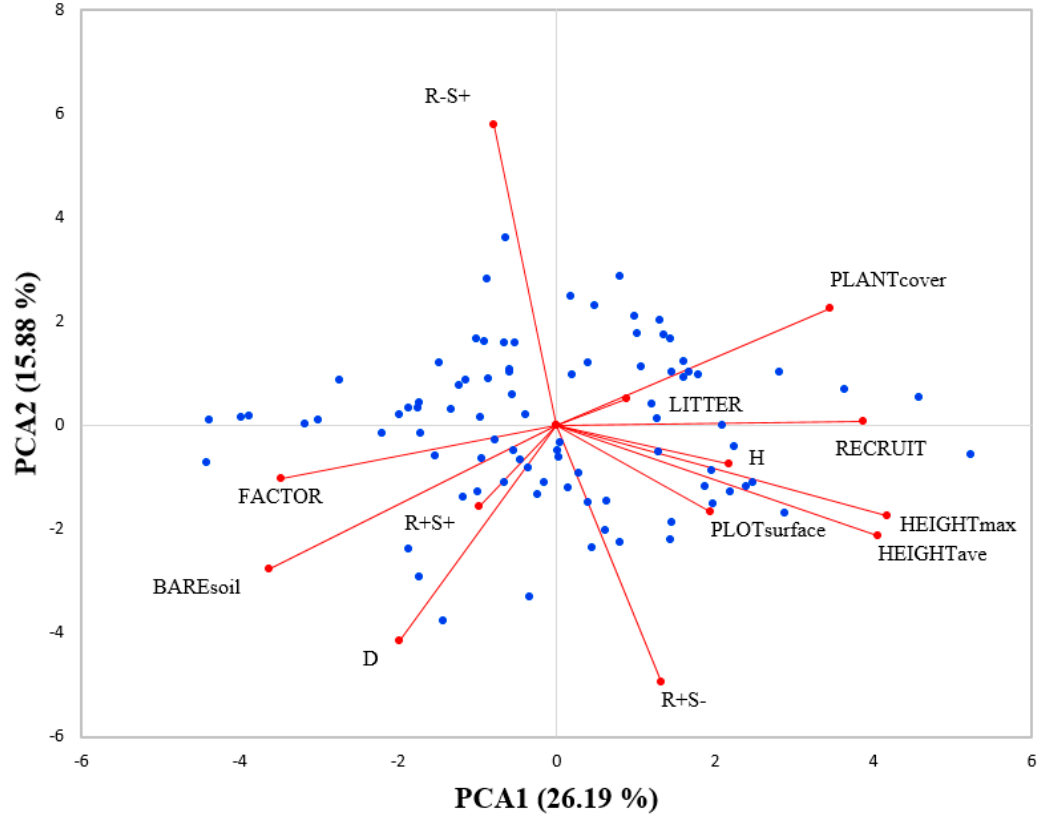
Figure 4. The principal component analysis (PCA) biplot diagram for the studied variables. FACTOR: burn severity and post-fire management; RECRUIT: pine sapling density; HEIGHTaver: average pine seeding height; HEIGHTmax: maximum pine seeding height; PLOTsurface: surface of the sampling plot; R + S-: relative cover of obligate resprouters; R-S + : relative cover of obligate seeders; R + S + : relative cover of facultative seeders; D : Simpson’s Dominance Index; H (cid:48) : Shannon’s Diversity Index; BAREsoil: percentage of uncovered soil; PLANTcover: percentage of plant coverage; LITTER: percentage of surface organic matter (du ff and woody debris). Blue dots represent standardized values of variables recorded after a wildfire event. PCA1: Pine recruitment and plant diversity patterns response to burn severity and post-fire management; PCA2: Post-fire adaptive